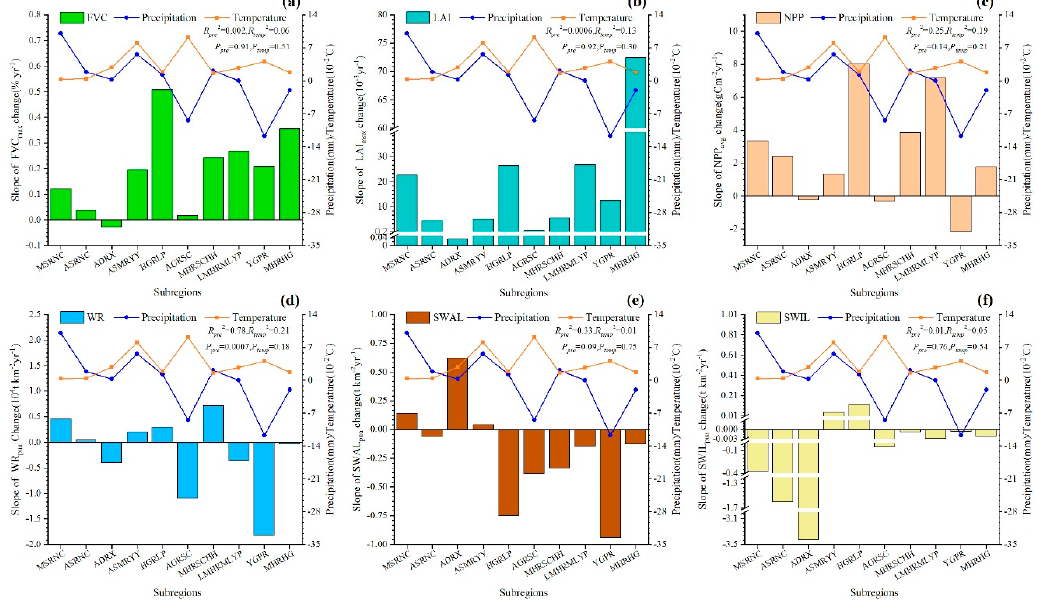
Figure 10. Relationship between the difference in ecological changes among Grain for Green Program (GGP) subregions and climate condition from 2000 to 2010. ( a – f ) are the slope of annual FVC max , LAI max , NPP avg , WR pua , SWAL pua , and SWIL pua changes compared with the slope of annual precipitation and temperature changes from 2000 to 2010, respectively.